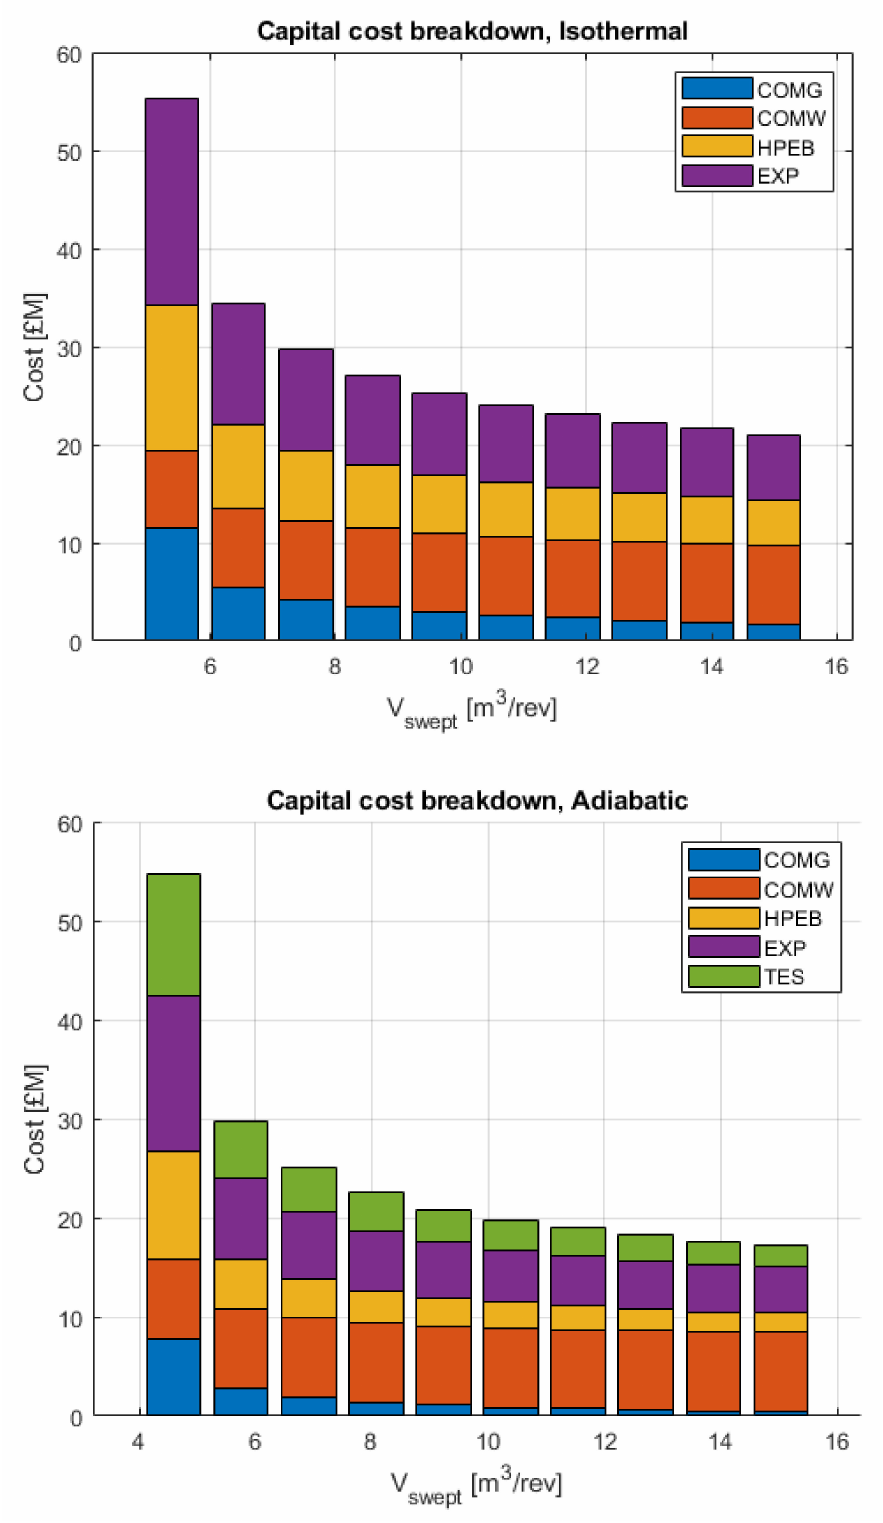
Figure 11. Breakdown of capital costs for an isothermal ( above ) and adiabatic ( below ) system with 200 h of